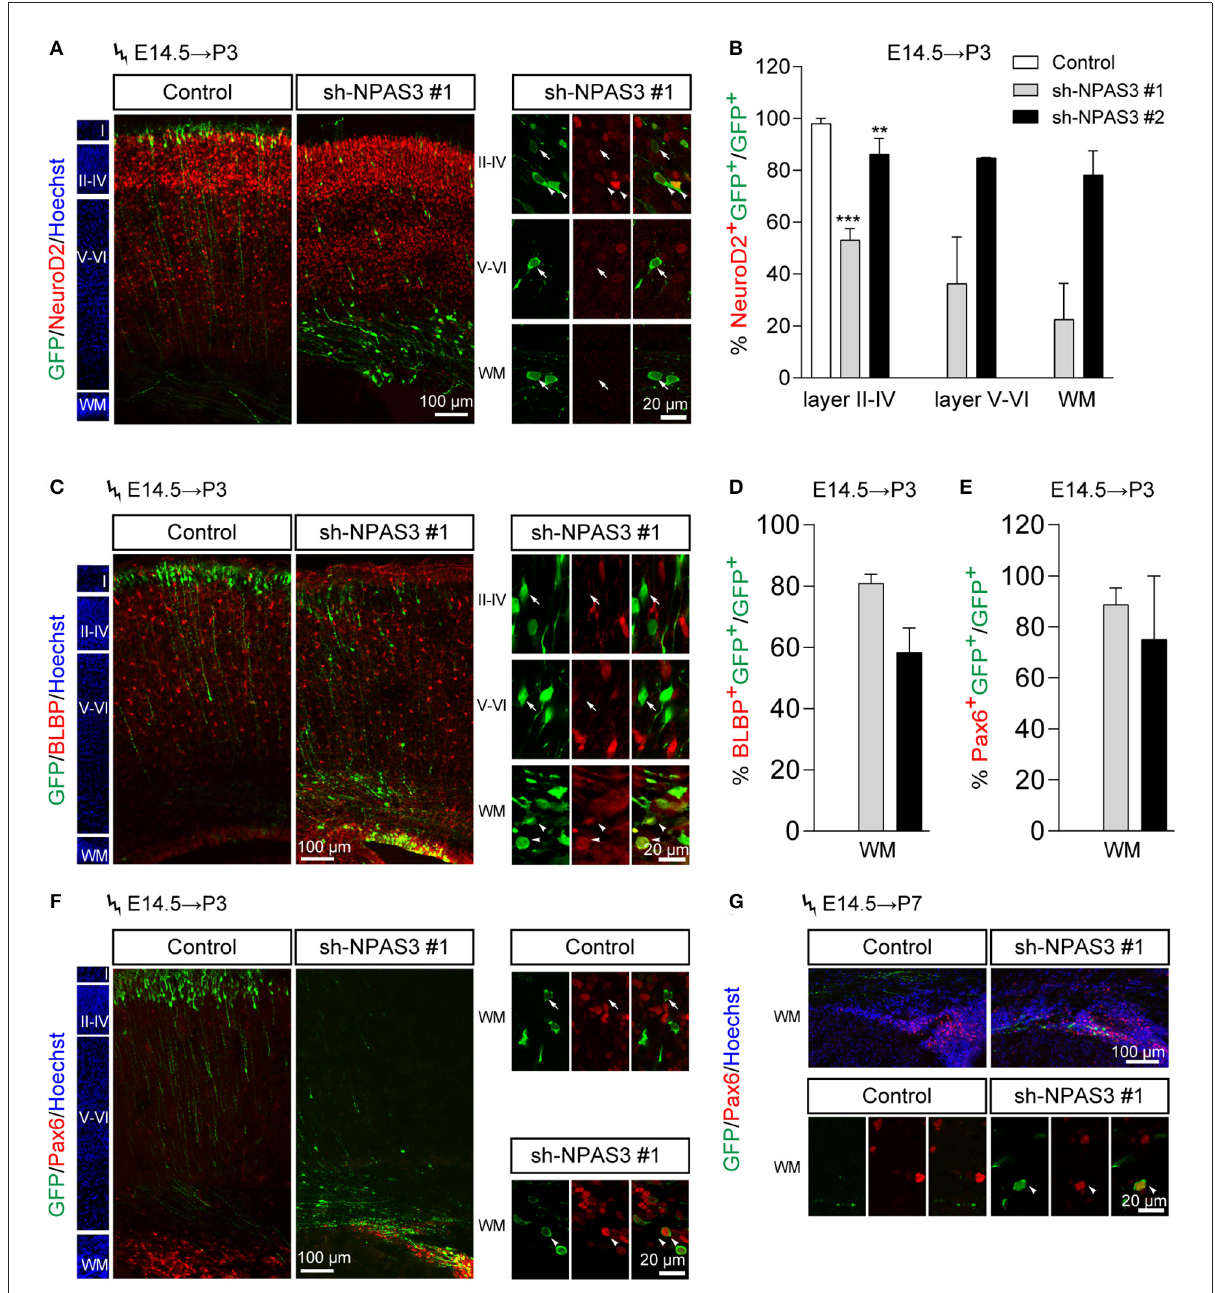
FIGURE4 Npas3 knockdown promoted the stemness maintenance of radial glial cells in the developing mouse cerebral cortex. Npas3 shRNAs or pSuper-basic control plasmid together with a GFP expression plasmid were electroporated into mouse embryos at E14.5. The brains of mouse pups were harvested at P3 or P7 and processed for immunostaining with anti-GFP antibody together with antibodies against one of the following markers: NeuroD2 (A) , BLBP (C) , and Pax6 (F, G) . Slices were counterstained with Hoechst (blue) to indicate lamination. High-magnification images of Npas3 knockdown cells layers II-IV, V and VI and WM were presented at the right or lower panel. Note that most Npas3 knockdown cells in layers II-IV were Neurod2 positive (arrowheads) and BLBP negative (arrows). In contrast, the majority of Npas3 knockdown cells in WM were NeuroD2 negative (arrows), but BLBP and Pax6 positive (arrowheads). Quantification of NeuroD2 positive cells from (A) , BLBP positive cells from (C) , and Pax6 positive cells from (F) are shown in (B) , (D) , and (E) , respectively, as % of total electroporated cells, ± SEM ( n = 3–5). One-way ANOVA test, ** p < 0.01, *** p < 0.001. WM, white matter; Cortical layers are labeled